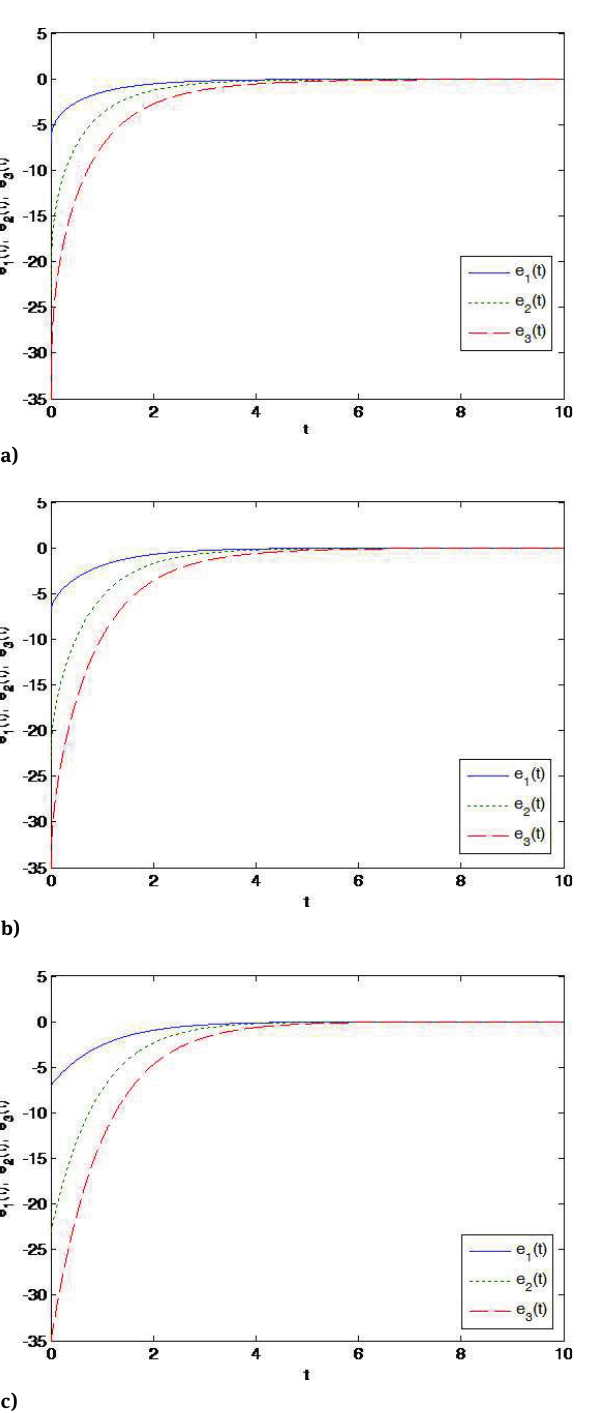
Fig. 4: The evolution of the error functions e 1 ( t ), e 2 ( t ) and e 3 ( t ) : (a) q = 0.92 , (b) q = 0.96 , (c) q = 1 , using active control method.